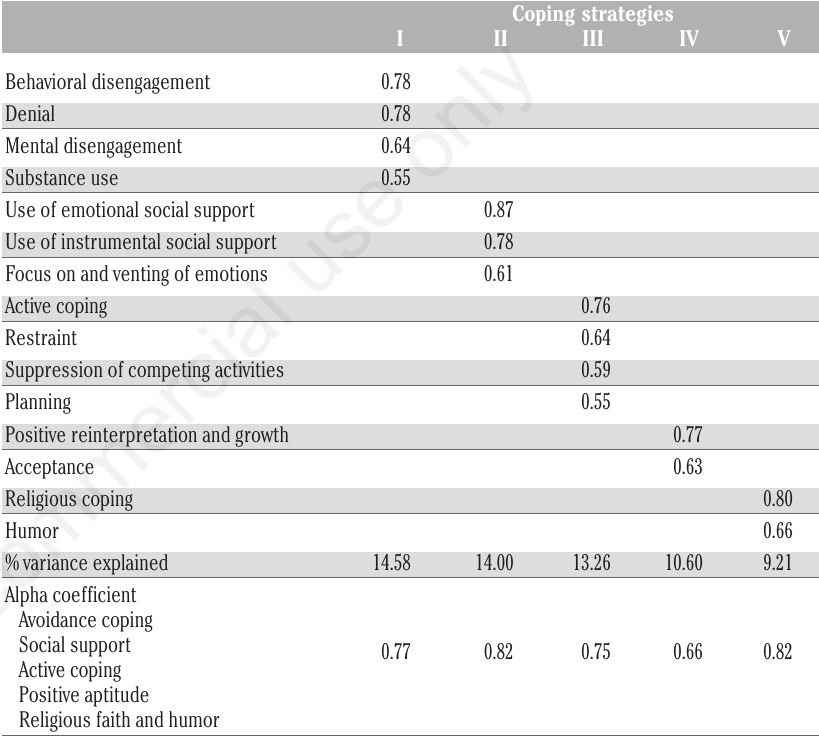
Table 1. Principal component analysis: scale loadings, explained variance and internal consistency.